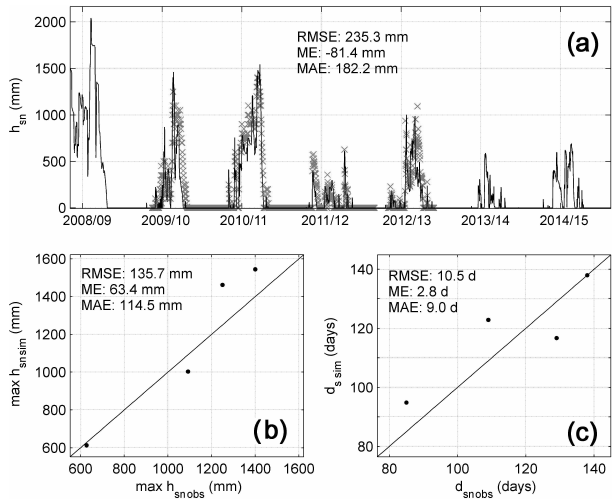
Figure 5. (a) Snow depth in millimetres simulated for each snow season at the Refugio Poqueira site from the hydrological year 2008/2009 to 2014/2015. The grey crosses show the observed snow depth for years 2009/2010 to 2012/2013. (b) Observed (obs) ver- sus simulated (sim) annual maximum snow depth in millimetres at this site. (c) Observed versus simulated annual duration of the snow depth in days at this site. The line at (b) and (c) indicates a 1:1 rela- tionship between observed and simulated values. Each plot includes the root mean square error (RMSE), the mean error (ME), and the mean absolute error (MAE).